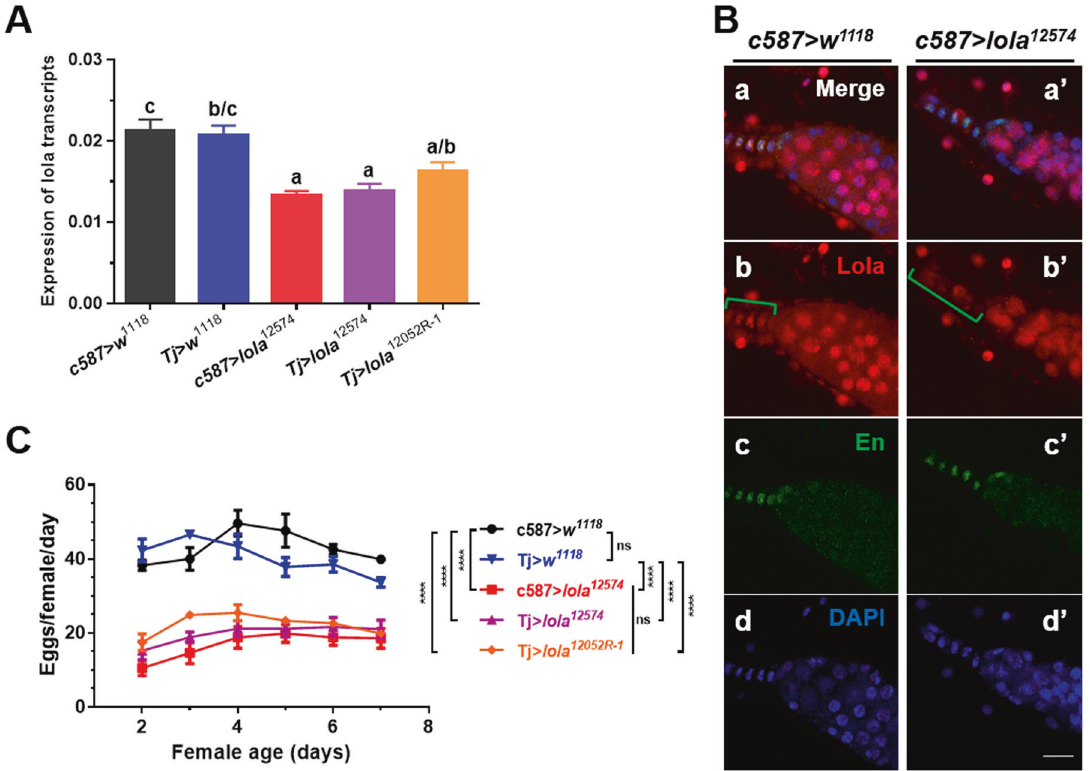
Fig. 2 Lola is required for female fertility. A Expression of lola transcripts in the ovaries of the c587 > lola 12574 , Tj > lola 12574 , Tj > lola 12052R-1 , c587 > w 1118 and Tj > w 1118 fl y lines. For each graph, different letters above bars indicate groups signi fi cantly differed from one another ( p < 0.05, one-way ANOVA followed by a post hoc Tukey ’ s honestly signi fi cant difference [HSD] test using GraphPad). B Adult ovaries from the control c587 > w 1118 line ( a-d ) and c587 > lola 12574 RNAi line ( a ’ -d ’ ) were immunostained with Lola and En antibodies, and nuclei were stained with DAPI. In the c587 > lola 12574 RNAi line, reduced Lola protein level was observed in TFCs compared to the c587 > w 1118 line (green brackets in b and b ’ ). C Female fertility tests were performed in the above fl y lines. Signi fi cant difference was determined by one-way ANOVA followed by a post hoc Tukey ’ s HSD test and indicated by asterisks: **** p < 0.0001; ns, non-signi fi cant. Scale bar: 10 µm in B